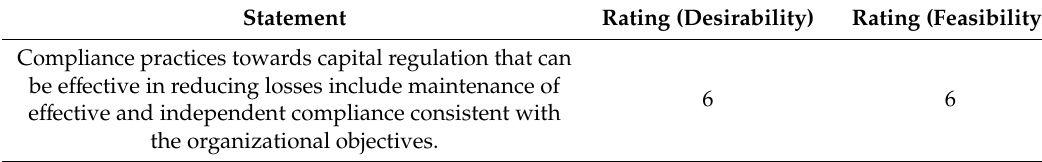
Table 3. Statements that Satisfied Consensus Threshold in Round